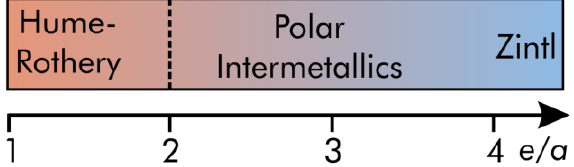
Figure 1. Overview [12] of different families of intermetallic phases as function of the valence-electron concentration ( e / a ).